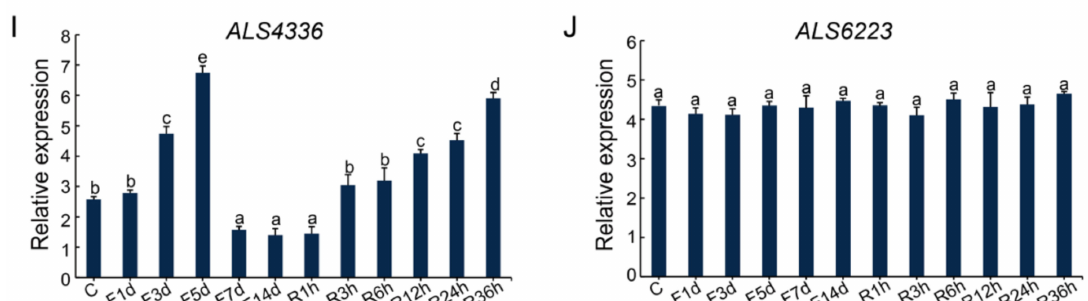
Figure 6. Effects of fasting and re-feeding on the expression of the IIS signaling pathway genes. C represents the control group; F1d, F3d, F5d, F7d, and F14d represent 1, 3, 5, 7, and 14 days after fasting, respectively; R1h, R3h, R6h, R12h, R24h, and R36h represent 1, 3, 6, 12, 24, and 36 h after re-feeding, respectively. ( A ) Effects of fasting and re-feeding on the expression of ILPR . ( B ) Effects of fasting and re-feeding on the expression of IRS . ( C ) Effects of fasting and re-feeding on the expression of IGFBPRP . ( D ) Effects of fasting and re-feeding on the expression of ALS5594 . ( E ) Effects of fasting and re-feeding on the expression of ALS7489 . ( F ) Effects of fasting and re-feeding on the expression of ALS2466 . ( G ) Effects of fasting and re-feeding on the expression of ALS1089 . ( H ) Effects of fasting and re-feeding on the expression of ALS7789 . ( I ) Effects of fasting and re-feeding on the expression of ALS4336. ( J ) Effects of fasting and re-feeding on the expression of ALS6223 . Data are expressed as the mean ± SD (n = 3). Significant differences ( p < 0.05) among the timepoints of fasting and re-feeding are indicated by the values with different letters. At all timepoints, the lowercase letter “a” represents the lowest expression level, and is significantly different from “b”, as well as other lowercase letters such as “c”, “d”, etc.